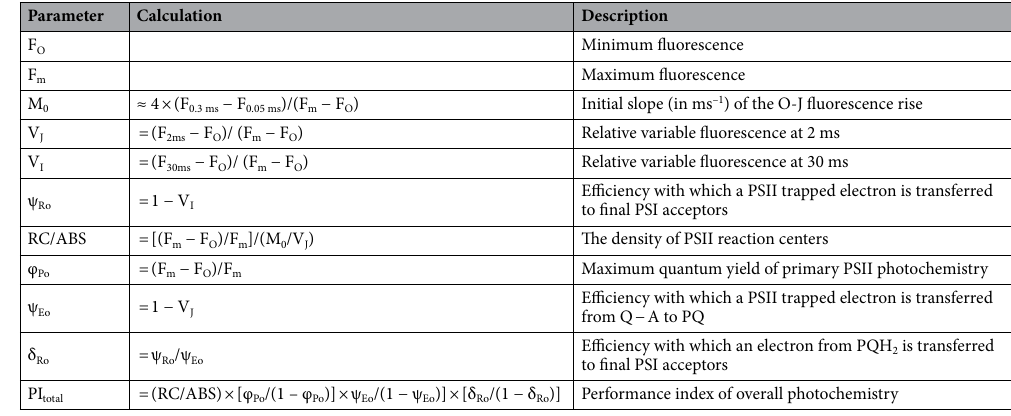
Table 2. The OJIP-derived parameters.